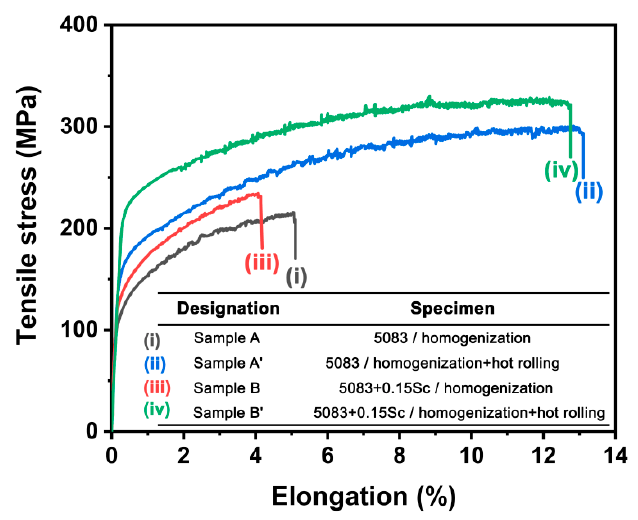
Figure 1. Tensile properties of the Al5083 alloy (sample A) and Sc-microalloyed Al5083 (sample B) alloy from the tensile tests of hot-rolled sample A (sample A ′ ) and sample B (sample B ′ ). Table 2. Tensile properties of Sc-free/microalloyed Al5083 alloys with/without the hot-rolling process.